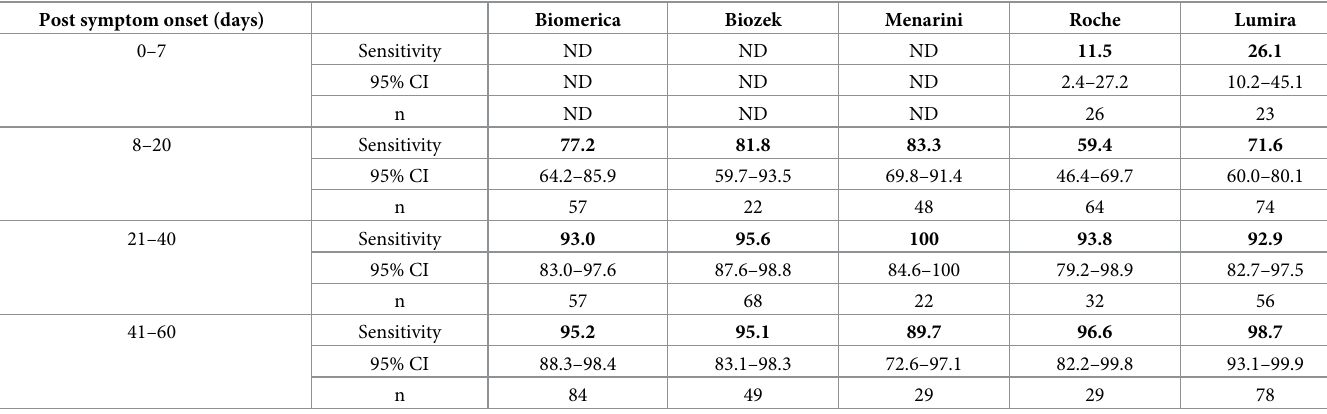
Table 2. Sensitivity against time.